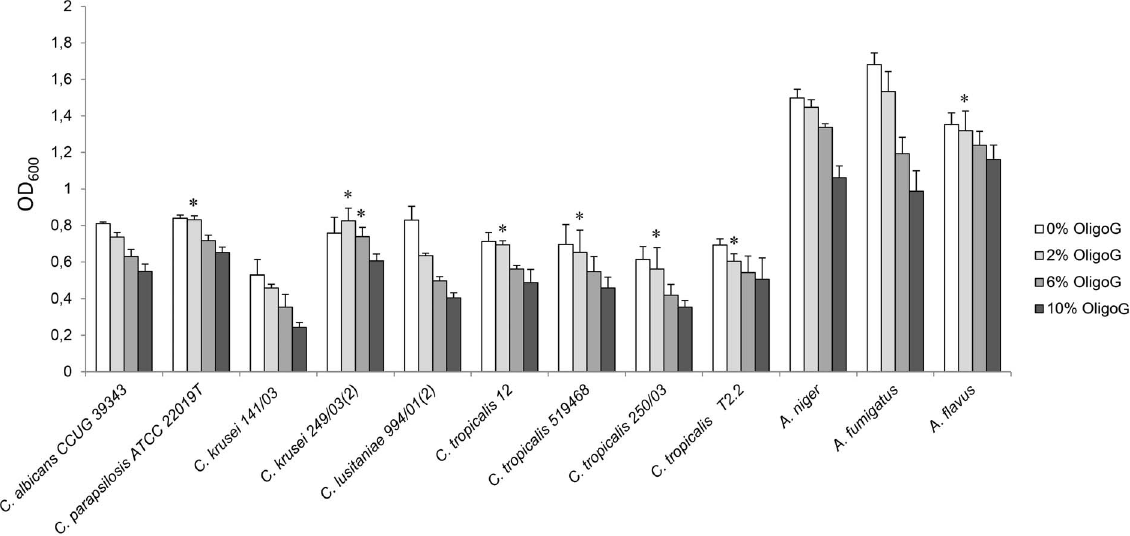
Figure 1. Effect of increasing concentrations of OligoG (0, 2, 6, and 10%) on cell densities. Cultivation in Mueller-Hinton broth for 48 h at 34 u C for various Candida and Aspergillus species. Error bars represent standard deviation from the mean (n $ 4). (*, data not significantly different from control results; P . 0.05).